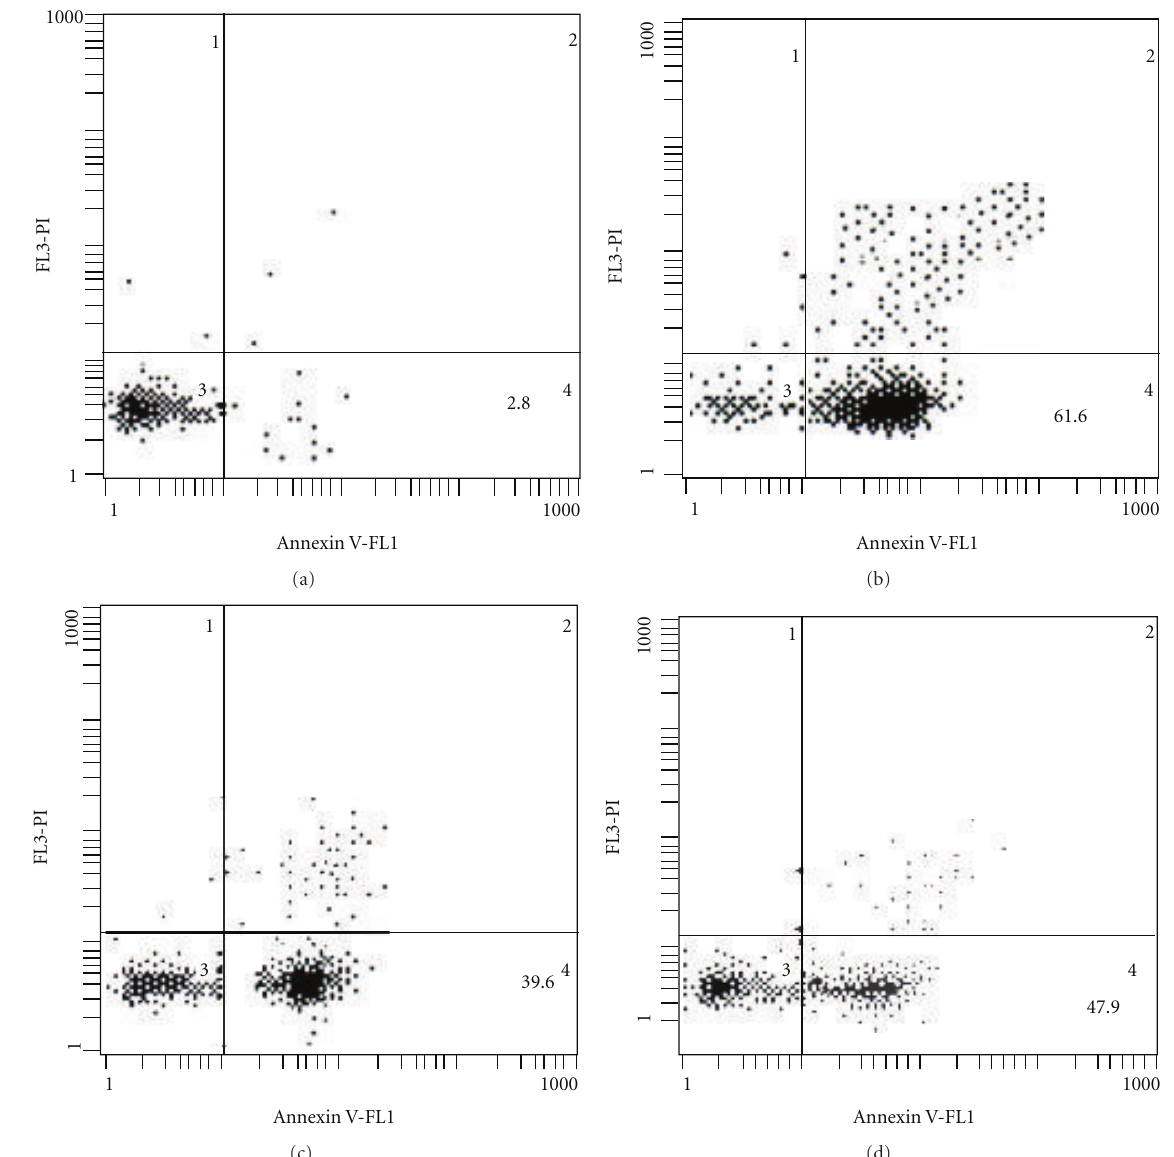
Figure 5: Detection of apoptosis in fibroblasts by flow cytometry. (a) Most of the fibroblasts in the SIG were alive, with only 2.8% of apoptotic cells. (b) The high-dose UVA irradiation (86.4 J/cm 2 ) strongly induced cellular apoptosis in cultured fibroblasts, with 61.6% apoptotic cells. (c and d) Preirradiation of low-dose UVA reduced cellular apoptosis induced by the subsequent lethal dose of UVA irradiation. Irradiation with 86.4 J/cm 2 UVA 6 h and 72h after preirradiation with a cumulative dose of 28.8 J/cm 2 , reduced the proportion of apoptotic cells to 39.6% (c), and 47.9% (d),